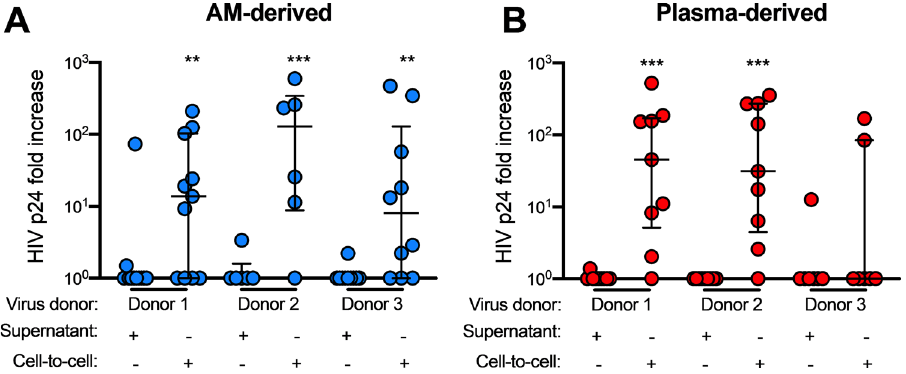
Figure 4. Viral constructs made with patient-derived HIV env from AMs and plasma productively infect MDMs more efficiently through T cell contact. Experimental conditions were as in Fig. 3 with the HIV constructs described in Fig. 2. Cells were infected with AM-derived ( A ) or plasma-derived ( B ) viral isolates from viral Donors 1, 2 or 3. CD4+ T cells and MDMs were isolated from the same blood donors. In ( A ), n = 11 cell donors for viral donor 1, n = 6 cell donors for viral donor 2, and n = 10 cell donors for viral donor 3; in ( B ), n = 9 cell donors for viral donor 1, n = 9 cell donors for viral donor 2, and n = 7 cell donors for viral donor 3. p value from Kruskal–Wallis test. Statistics compare the fold change at the final timepoint to day 1. ** p < 0.01, *** p < 0.001.